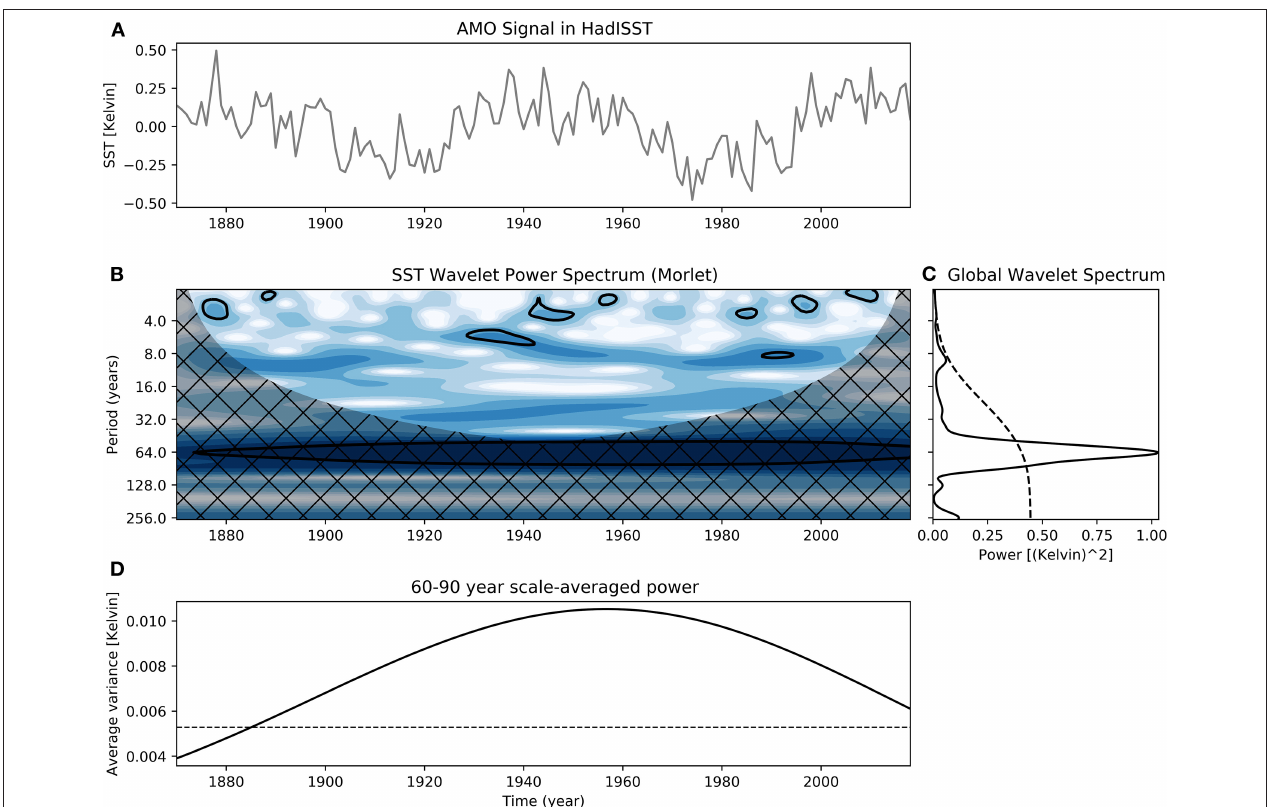
FIGURE 1 | (A) Observed AMO index calculated from annual HadISST data since 1871 (Rayner et al., 2003), (B) corresponding continuous wavelet transform of the AMO index, (C) wavelet power spectrum integrated over time, and (D) average variance in the period band 60–90 years. The black contour lines show statistical significance according to Grinsted et al. (2004). The cone of influence where edge effects might influence the results is hatched (Grinsted et al.,